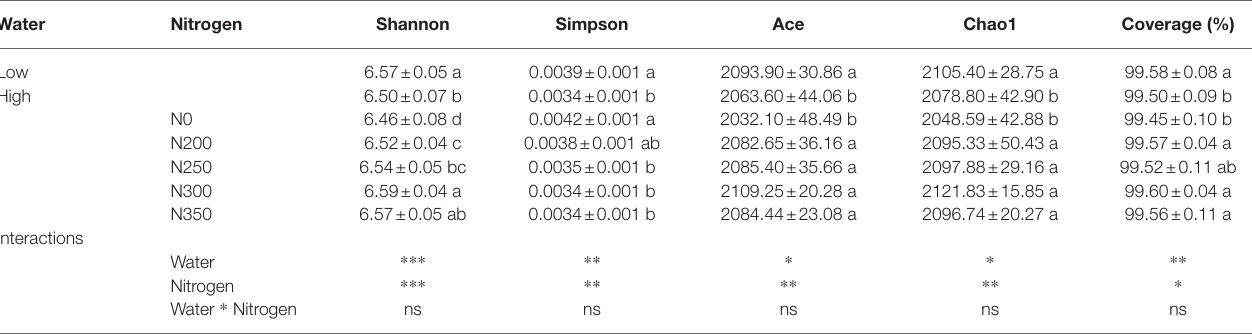
TABLE 3 | Effect of different treatments and the interaction between irrigation water and N fertilization rate on the richness and diversity of the bacteria community. Water Nitrogen Shannon